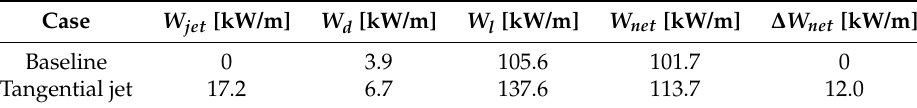
Table 3. Estimate of power for jet generation, power to overcome the drag, power from the lift, and the net power during the pitch